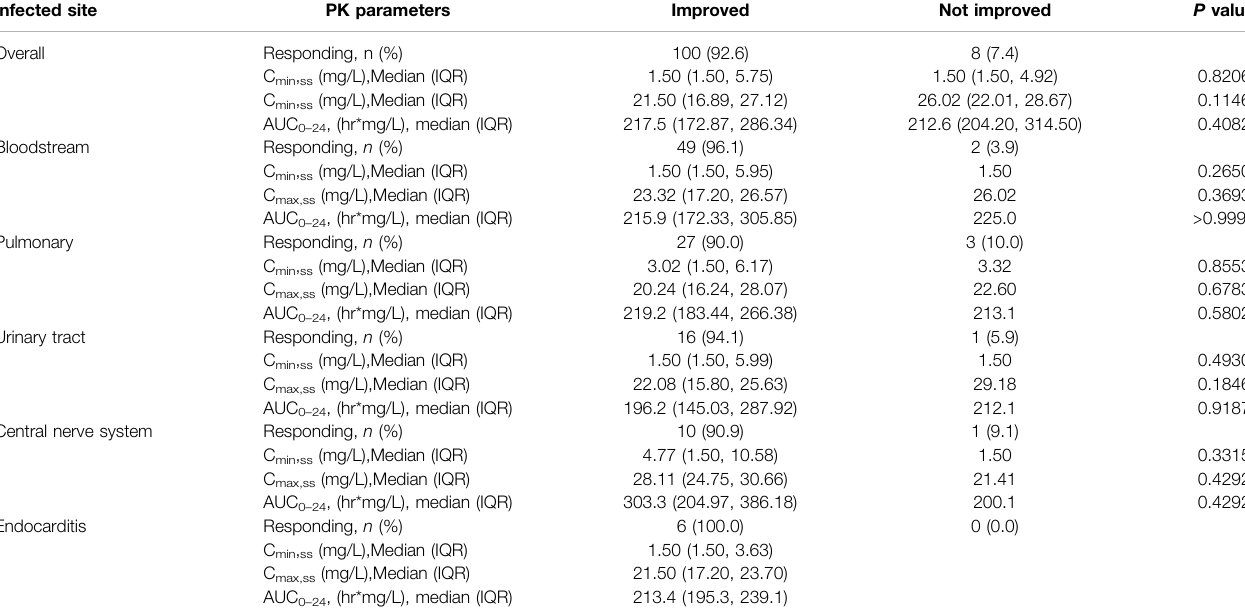
TABLE 4 | Comparison of pharmacokinetic parameters and clinical ef fi cacy (improvement of clinical signs and symptoms) by the most common infected sites. Infected site